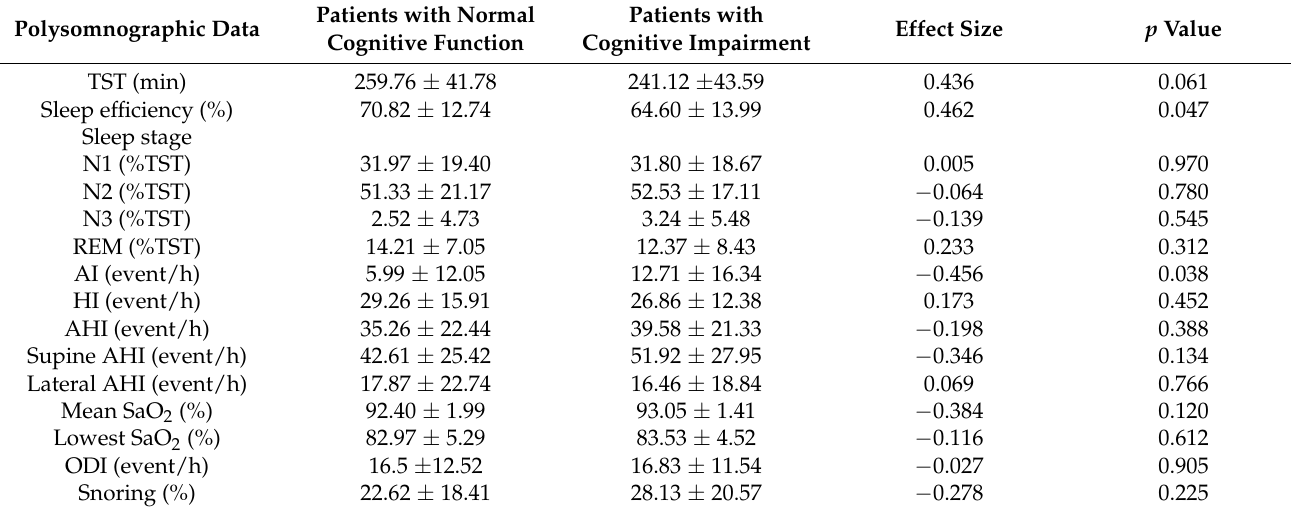
Table 2. Comparison of sleep profiles between normal and cognitive impairment groups.